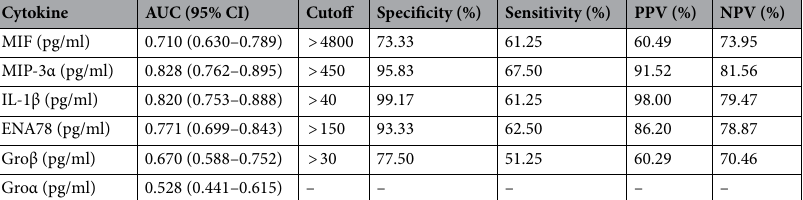
Cytokine AUC (95% CI)